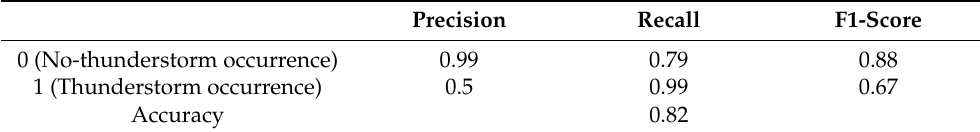
Table 1. The confusion matrix for the classification model in Patna is as follows. Precision Recall F1-Score